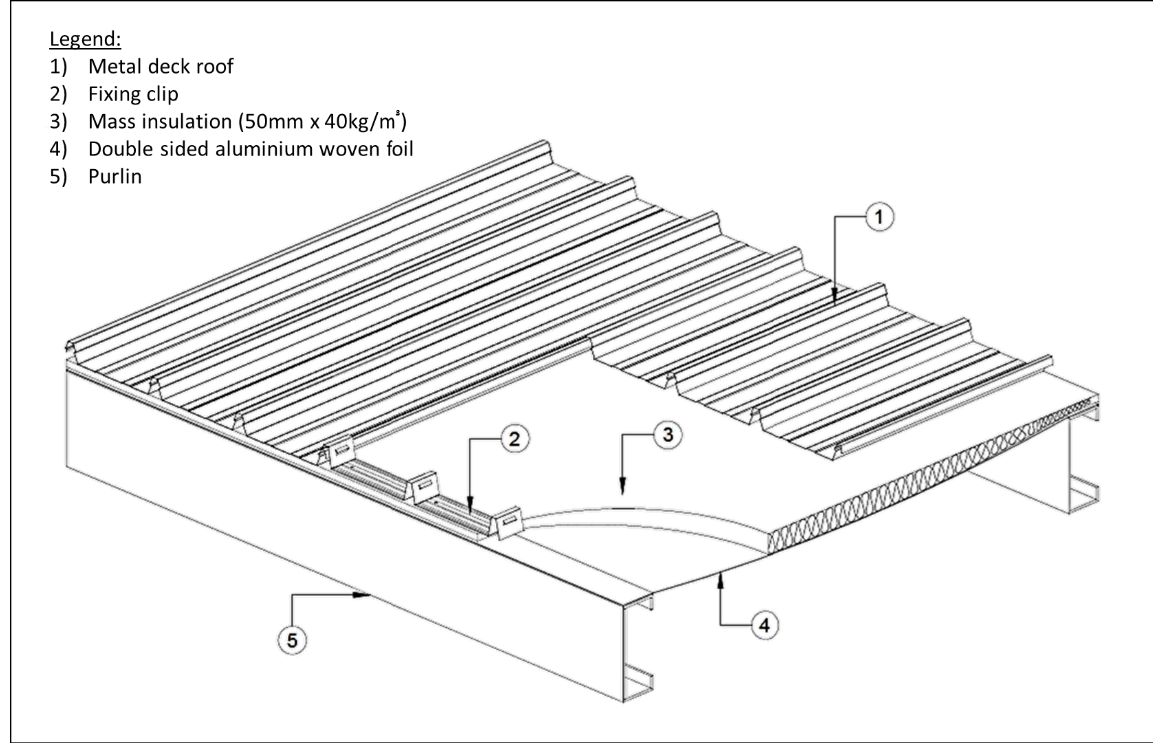
Figure 3: Metal deck with mass insulation and RI (Source: Swissma Roofing Malaysia)